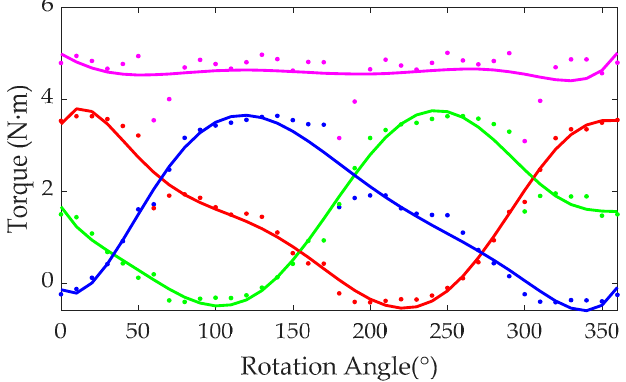
Figure 8. Torque comparison of three blades.